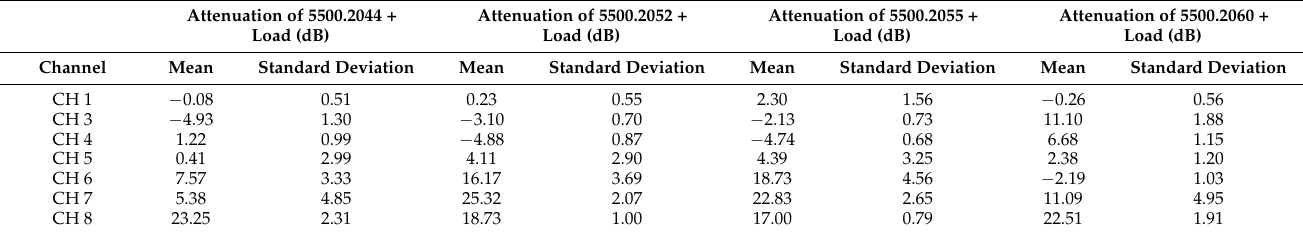
Table 6. Mean and standard deviation of signal attenuation due to the EMC filters when connecting a load to L’-N’. Attenuation of 5500.2044 + Attenuation of 5500.2052 + Attenuation of 5500.2055 + Attenuation of 5500.2060 + Load (dB) Load (dB) Load (dB) Load (dB) Channel Mean Standard Deviation Mean Standard Deviation Mean Standard Deviation Mean Standard